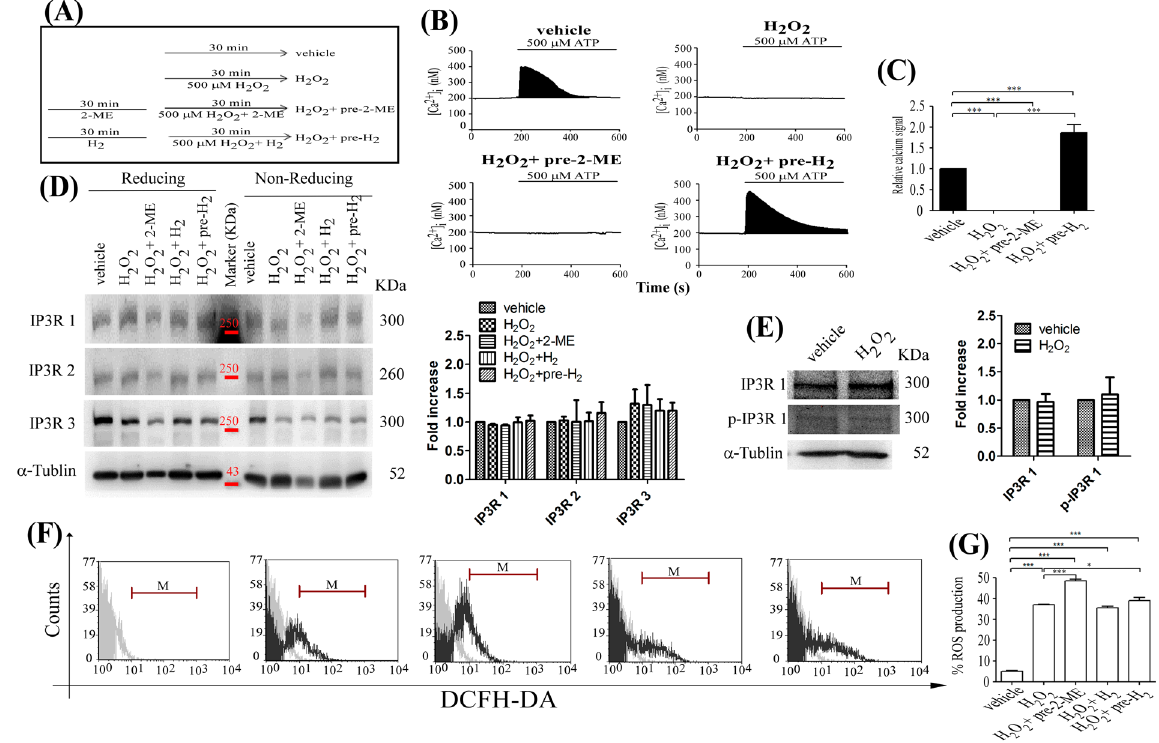
Figure 5. H 2 decreased disulfide bond formation but not ROS production in H 2 O 2 -exposed KC. ( A ) Effect of pretreatment with 2-ME-BSS or H 2 -BSS on the H 2 O 2 -induced reduction of ATP-induced Ca 2 + signal in KC. Experimental design for treatment in each group: vehicle, 500 μ M H 2 O 2 , 500 μ M H 2 O 2 + pre-2-ME, and 500 μ M H 2 O 2 + pre-H 2 . Ca 2 + signal was induced by ATP stimulation in each group ( B ) and calculated by the black- colored areas under the Ca 2 + curve (N = 3) ( *** P < 0.005) ( C ). ( D ) Expression of IP 3 Rs under non-reduced and reduced conditions is shown using SDS-PAGE and Western blot. Protein extracts from each group were resolved in non-reducing (without 2-ME) SDS-PAGE (7% gel), transferred onto Hybond-P polyvinylidene fluoride membranes, and incubated with antibodies against IP 3 R1, IP 3 R2 and IP 3 R3 and α -Tublin. As a control, the lysates were reduced using 100 mM 2-ME (reduced; right lanes). Proteins that form disulfide bonds exhibit faster migration and thus appear as lower molecular weight bands. Quantify of IP 3 Rs expression in reduced gel as shown in right panel in represent the average of three independent experiments. ( E ) Western blot analysis of the expression of IP 3 R1 and phosphorylated IP 3 R1 (p- IP 3 R1) after incubation of the cells with or without 500 μ M H 2 O 2 . Treatment with 500 μ M H 2 O 2 had no effect on the density of the bands for phosphorylated-IP 3 R1 (p-IP 3 R1), IP 3 R1 or α -Tublin. Quantify of expression in IP3R1 and p-IP3R1 as shown in right panel in represent the average of three independent experiments. ( F ) Flow cytometry was used to estimate the ( G ) ratio of ROS generation in each group ( * P < 0.05; *** P <